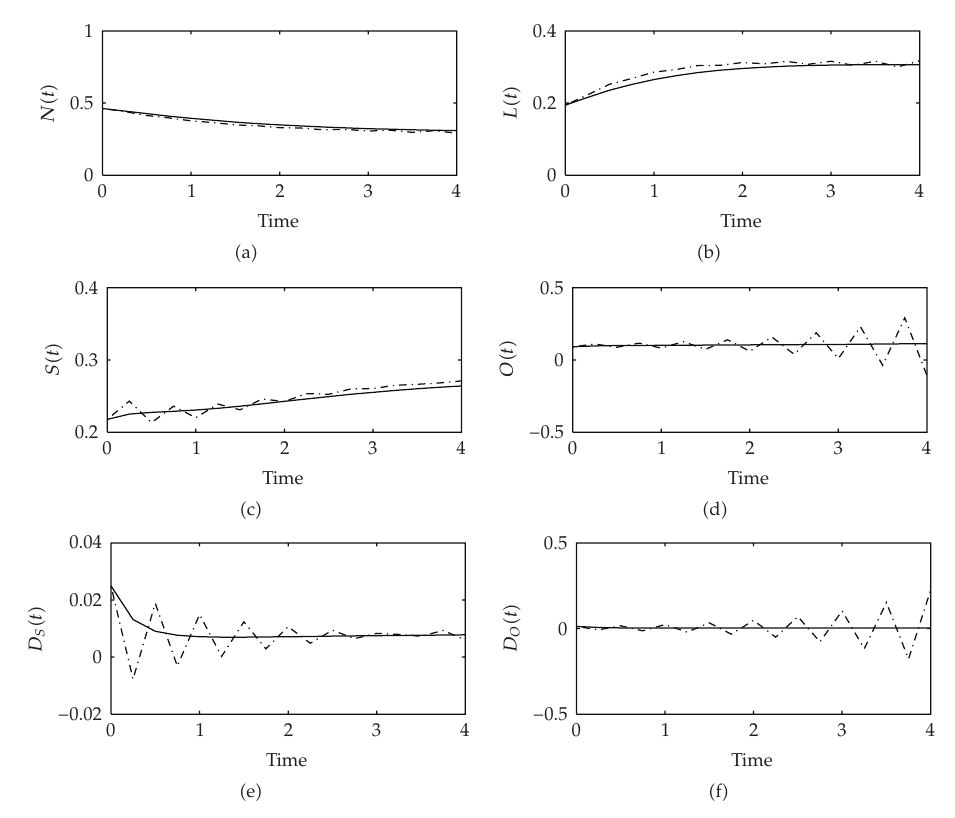
Figure 4: Profiles of subpopulations N (cid:3) t (cid:6) , L (cid:3) t (cid:6) , S (cid:3) t (cid:6) , O (cid:3) t (cid:6) , D S (cid:3) t (cid:6) , and D O (cid:3) t (cid:6) . Solutions are obtained by Euler scheme (cid:3) dashed (cid:6) and developed NSFD scheme (cid:3) line (cid:6) with ψ (cid:3) h (cid:6) (cid:7) h and h (cid:7) 0 . 25 for system (cid:3) 2.1 (cid:6)